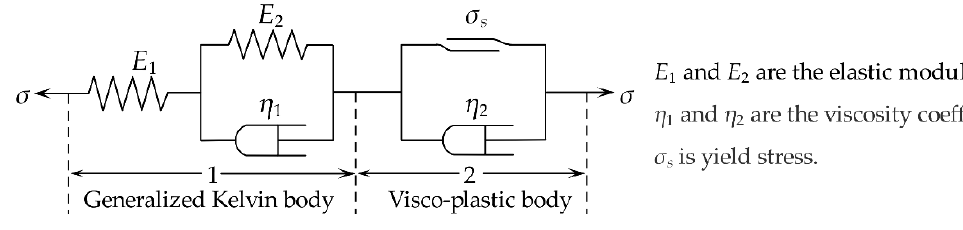
Figure 7. Classical Nishihara model.